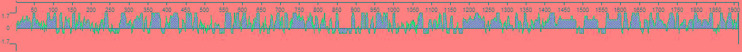
Analysis of the antigenic index of TgDOC2 protein by DNAStar 8.0 software with the Jameson-Wolf index. Linear B-cell epitopes were predicted to widely distribute in the whole TgDOC2 protein but were mainly clustered in the C-terminal.